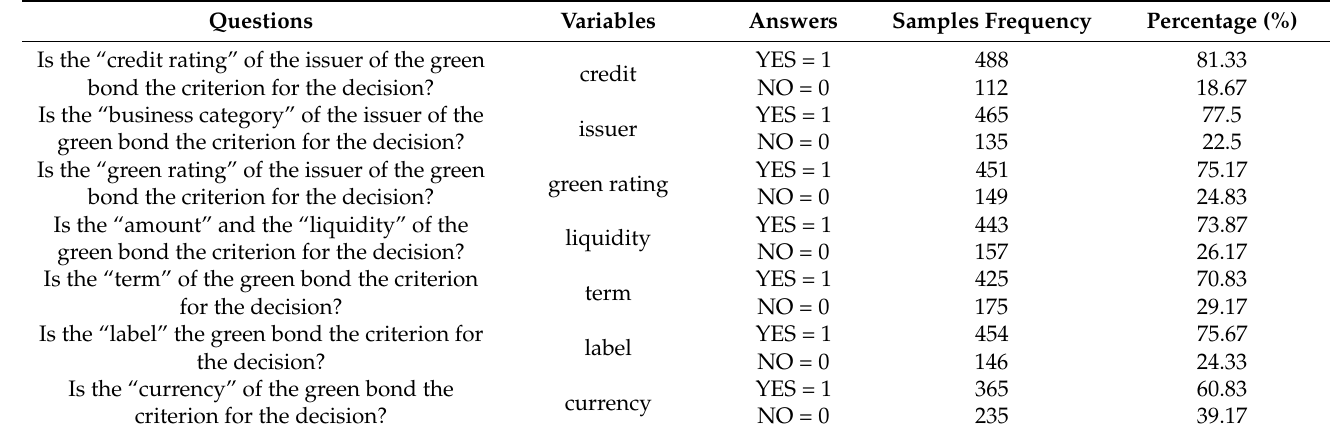
Table 3. Summary of the variables of the sample respondents ( n = 600).